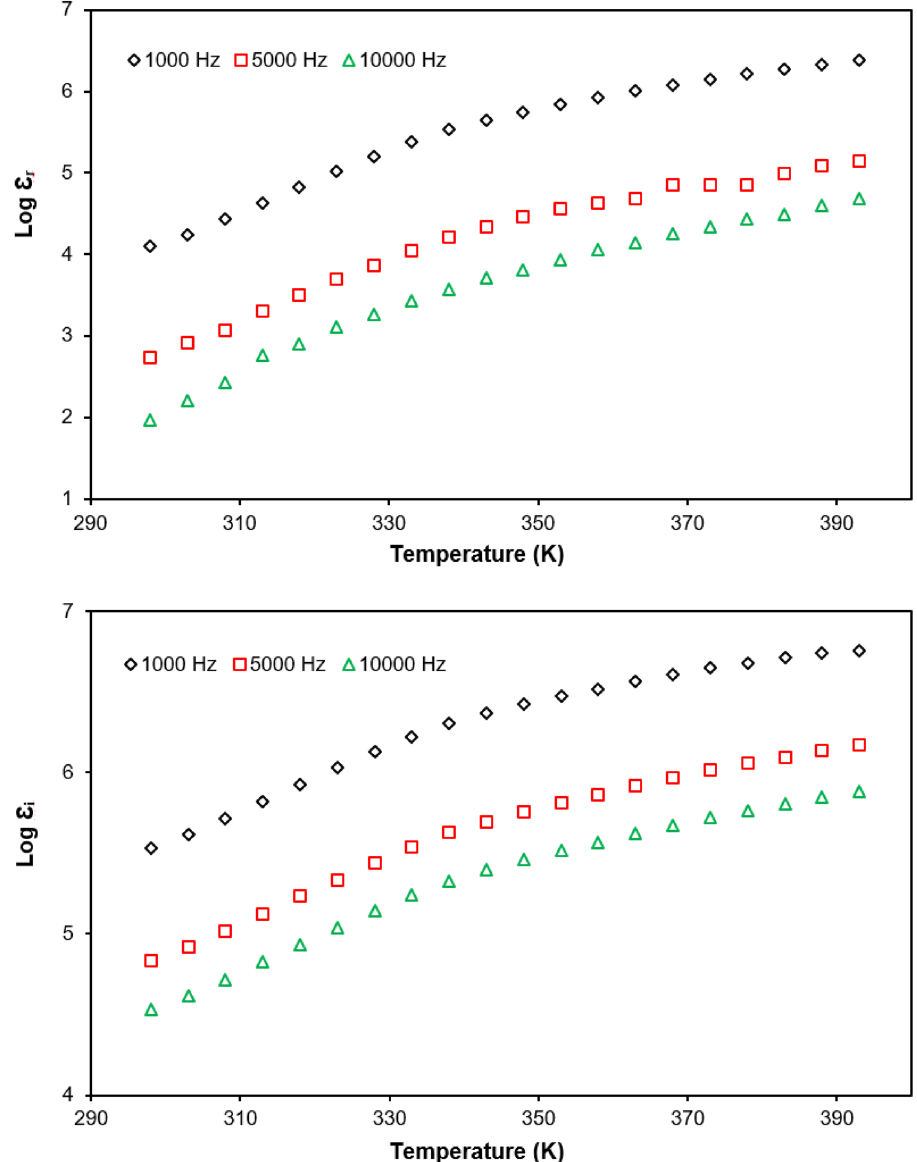
Figure 8. ( a ) Dielectric constant and ( b ) dielectric loss for PUA-30 wt% TBAI-I 2 GPE at selected